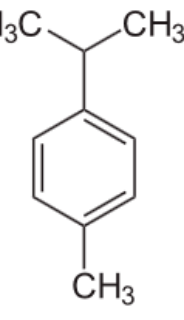
Figure 1. Chemical structure of p-cymene [17].